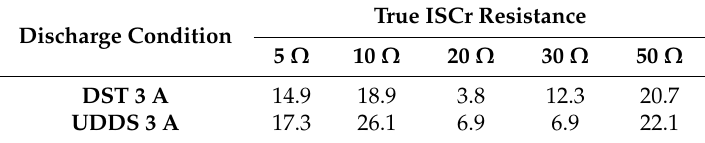
Table 6. Relative error (%) of the final value of 𝑅 𝐼𝑆𝐶𝑓 ̅̅̅̅̅̅̅ depending on the ISCr faults in the experiment with cell B.